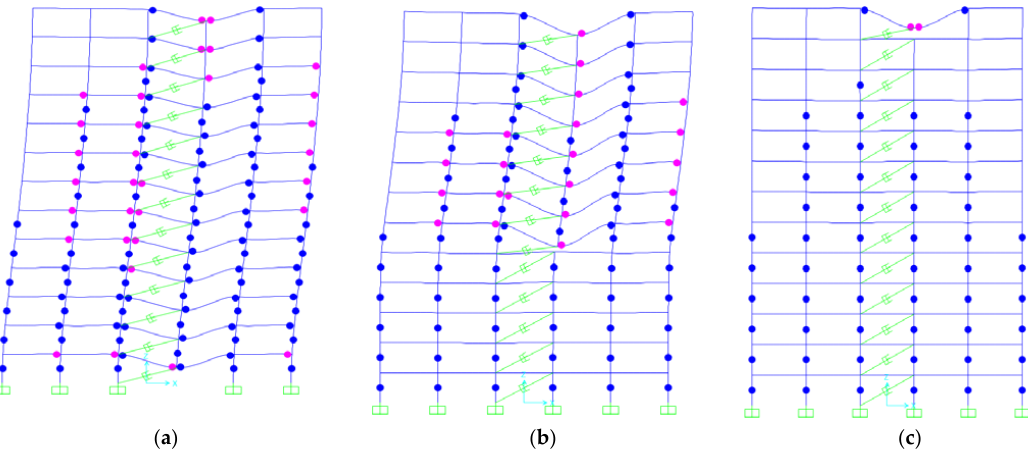
Figure 11. Hinge formation in the viscously damped frame in central bay exposed to column removal in ( a ) story one, ( b ) story six, and ( c ) story thirteen.